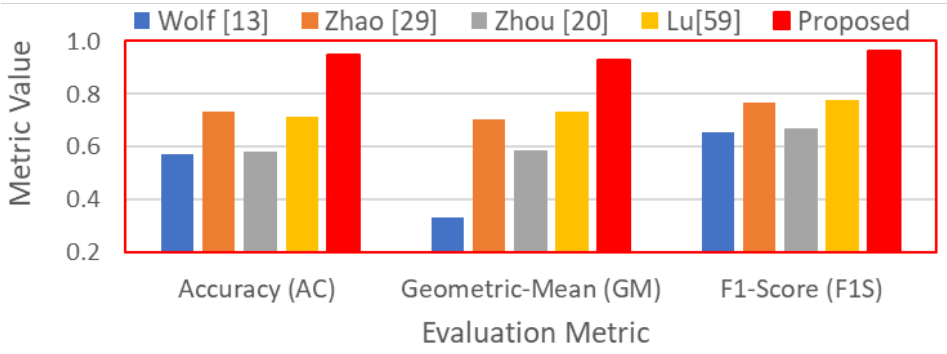
Figure 12 . Average performances of individual methods for scenes in the MSPI dataset. Figure 12. Average performances of individual methods for scenes in the MSPI